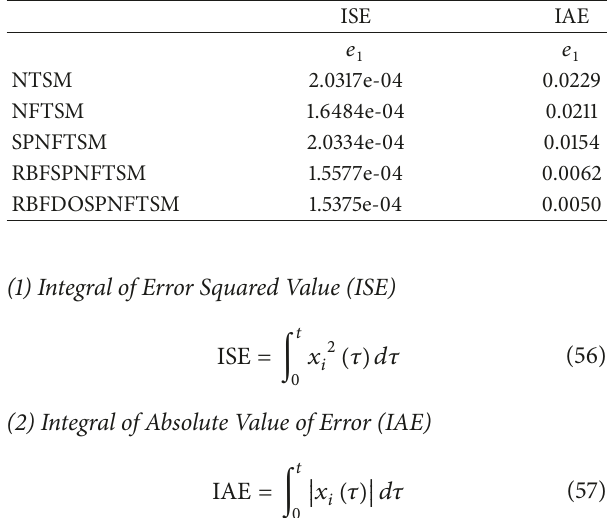
Figure 4: Swing speed response curve.